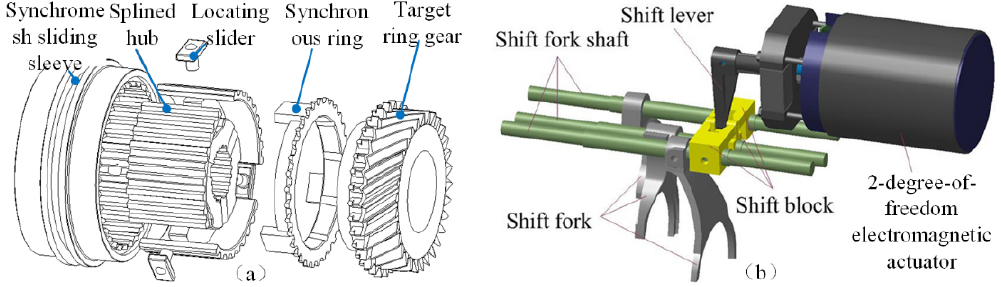
Figure 1. The scheme of the transmission: ( a ) the structure of the locking ring synchronizer; ( b ) two-degrees-of-freedom direct-drive electromagnetic gearshift system.